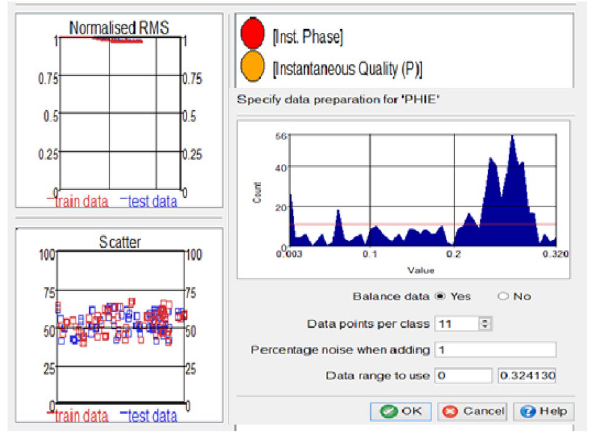
Fig. 15 Effective porosity time slice at top of reservoir 2